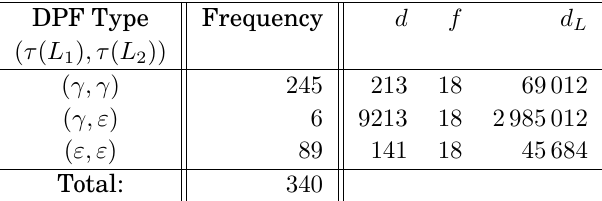
Table 20: Types of doublets with two non-split prime divisors of irregular f